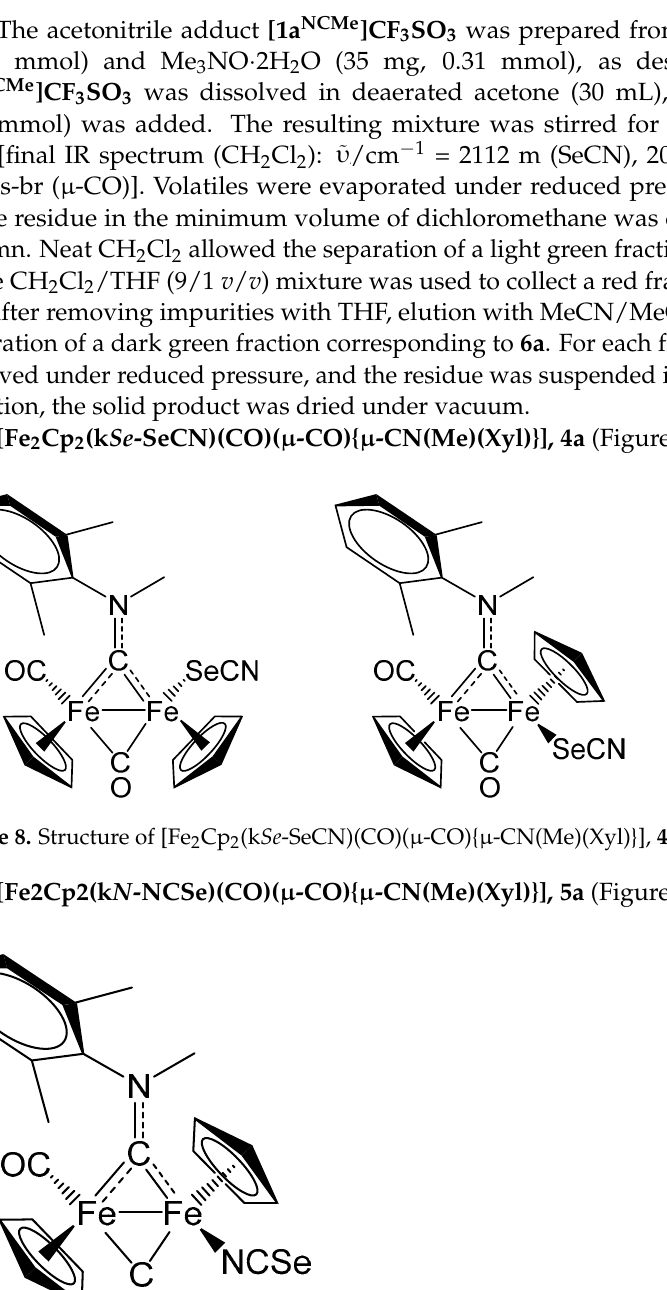
Figure 4. Structure of [Fe 2 Cp 2 (k N- NCO)(CO)(µ-CO){µ-CN(Me)(Xyl)}], 2a .